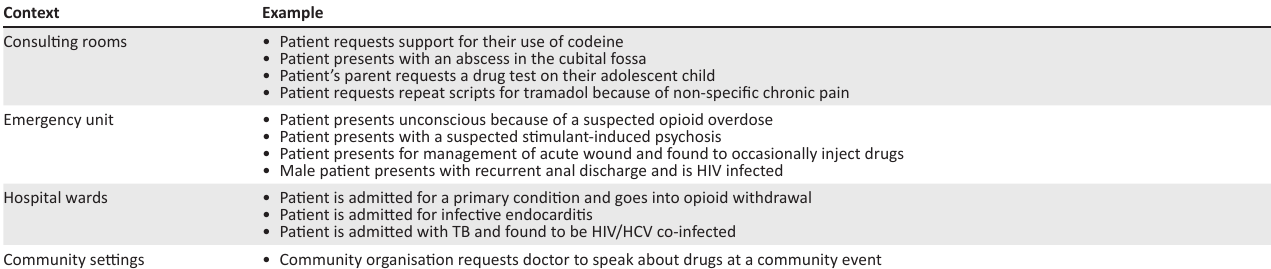
TABLE 1-A2: Examples of scenarios where drug use screening and management is required.